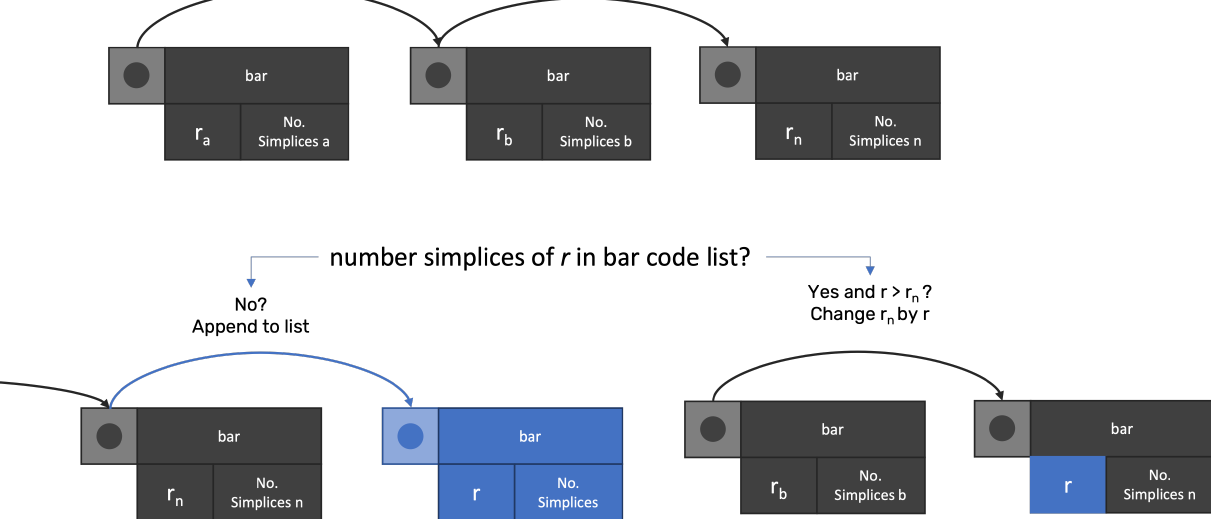
Figure 3. After building the simplices for distance r , the method searches any node in the Bar Code list with the same number of simplices. If no node matches the search, a new node is created, storing distance r and the number of simplices. If a match happens, it checks if the distance is higher than r and changes it if